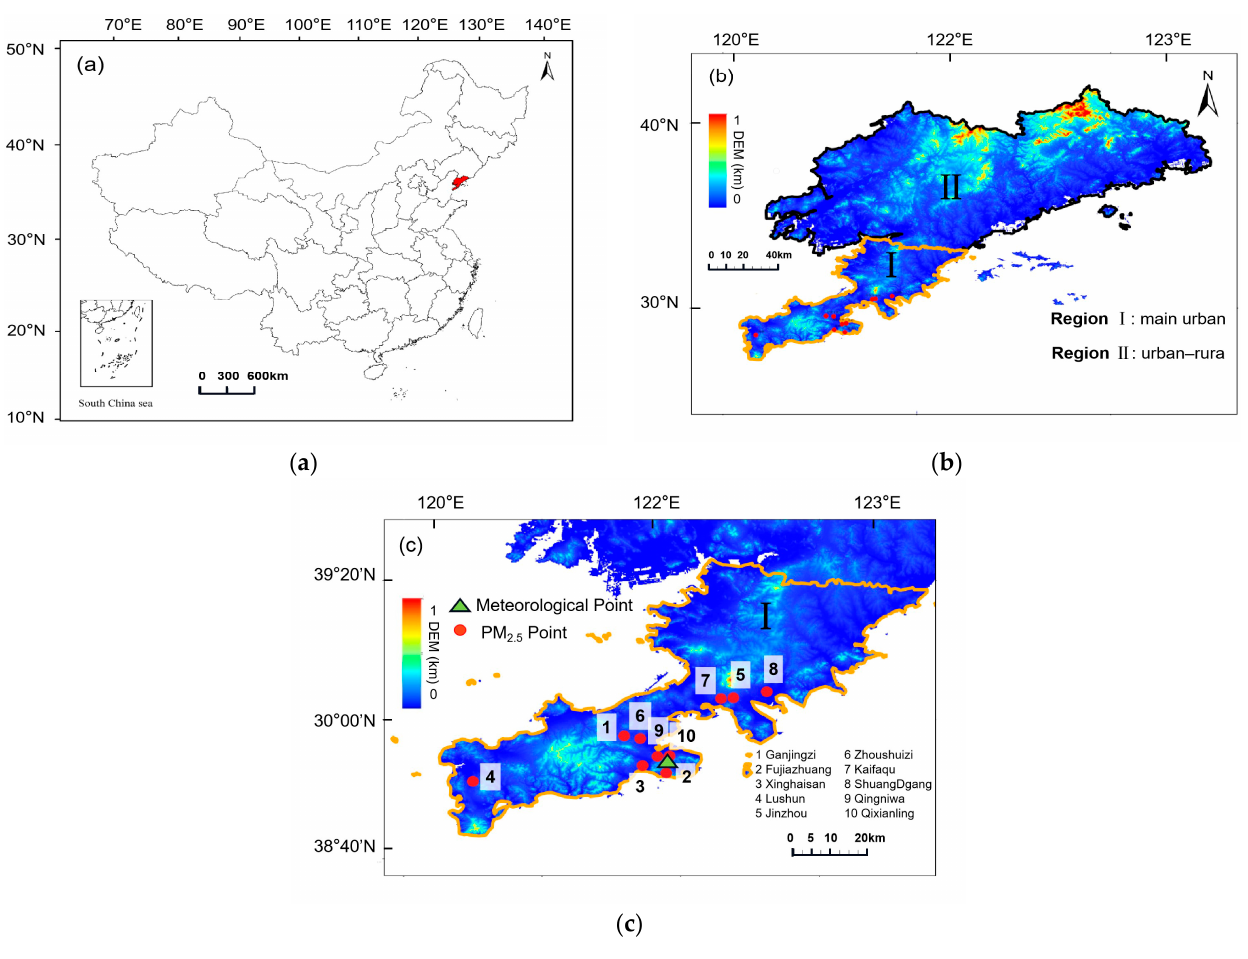
Figure 1. Map of ( a ) China. Elevation map of ( b ) Dalian and ( c ) main urban areas of Dalian. ( b ) Dalian main urban region and urban–rural region. ( c ) Spatial distributions of PM 2.5 point in Dalian.